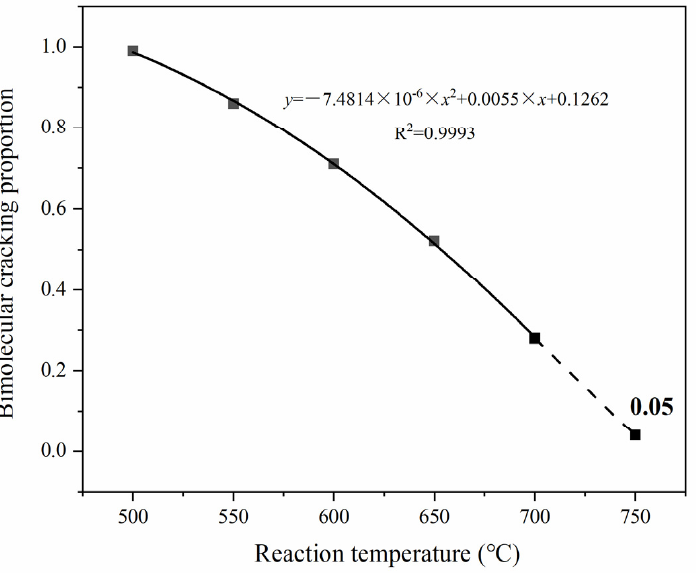
Figure 10. Possible cracking pathways of pentene (full line circle represents all cracking, dotted line circle represents part cracking).